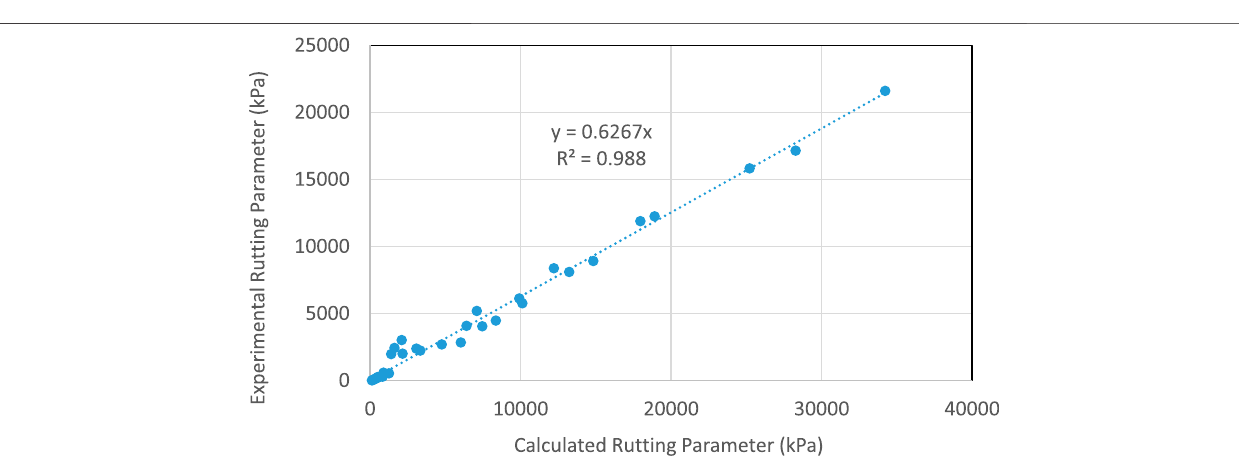
FIGURE 12 | Predicted vs. experimental rutting parameter for the aged modi fi ed CMAs: Modeling points.